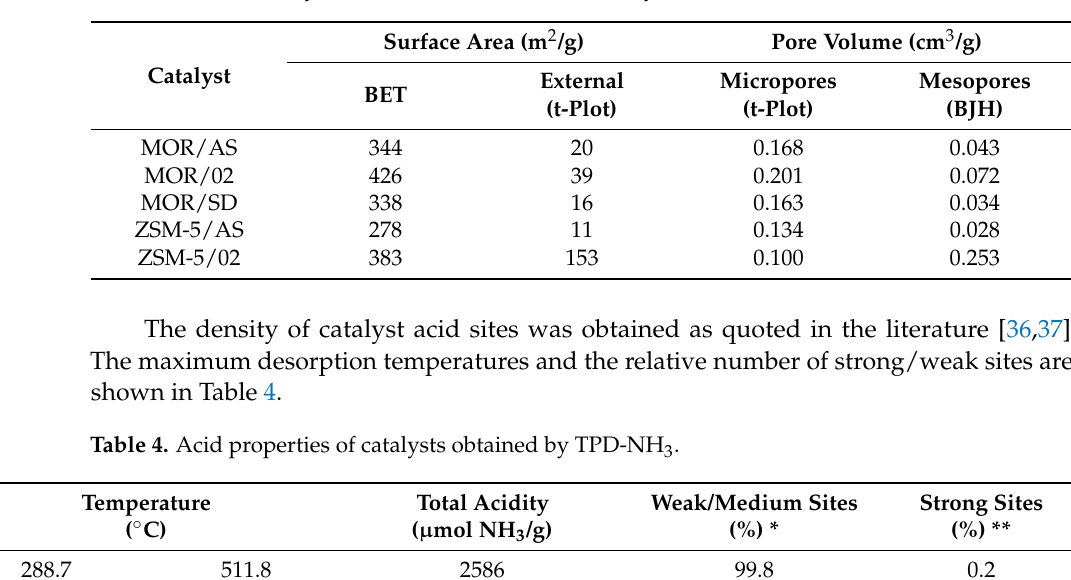
Table 3. Textural analysis data of MOR and ZSM-5 catalysts.